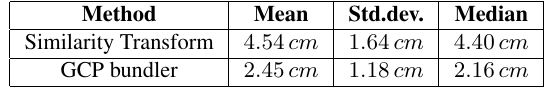
Table 2: Accuracy improvement by GCP constrained bundle